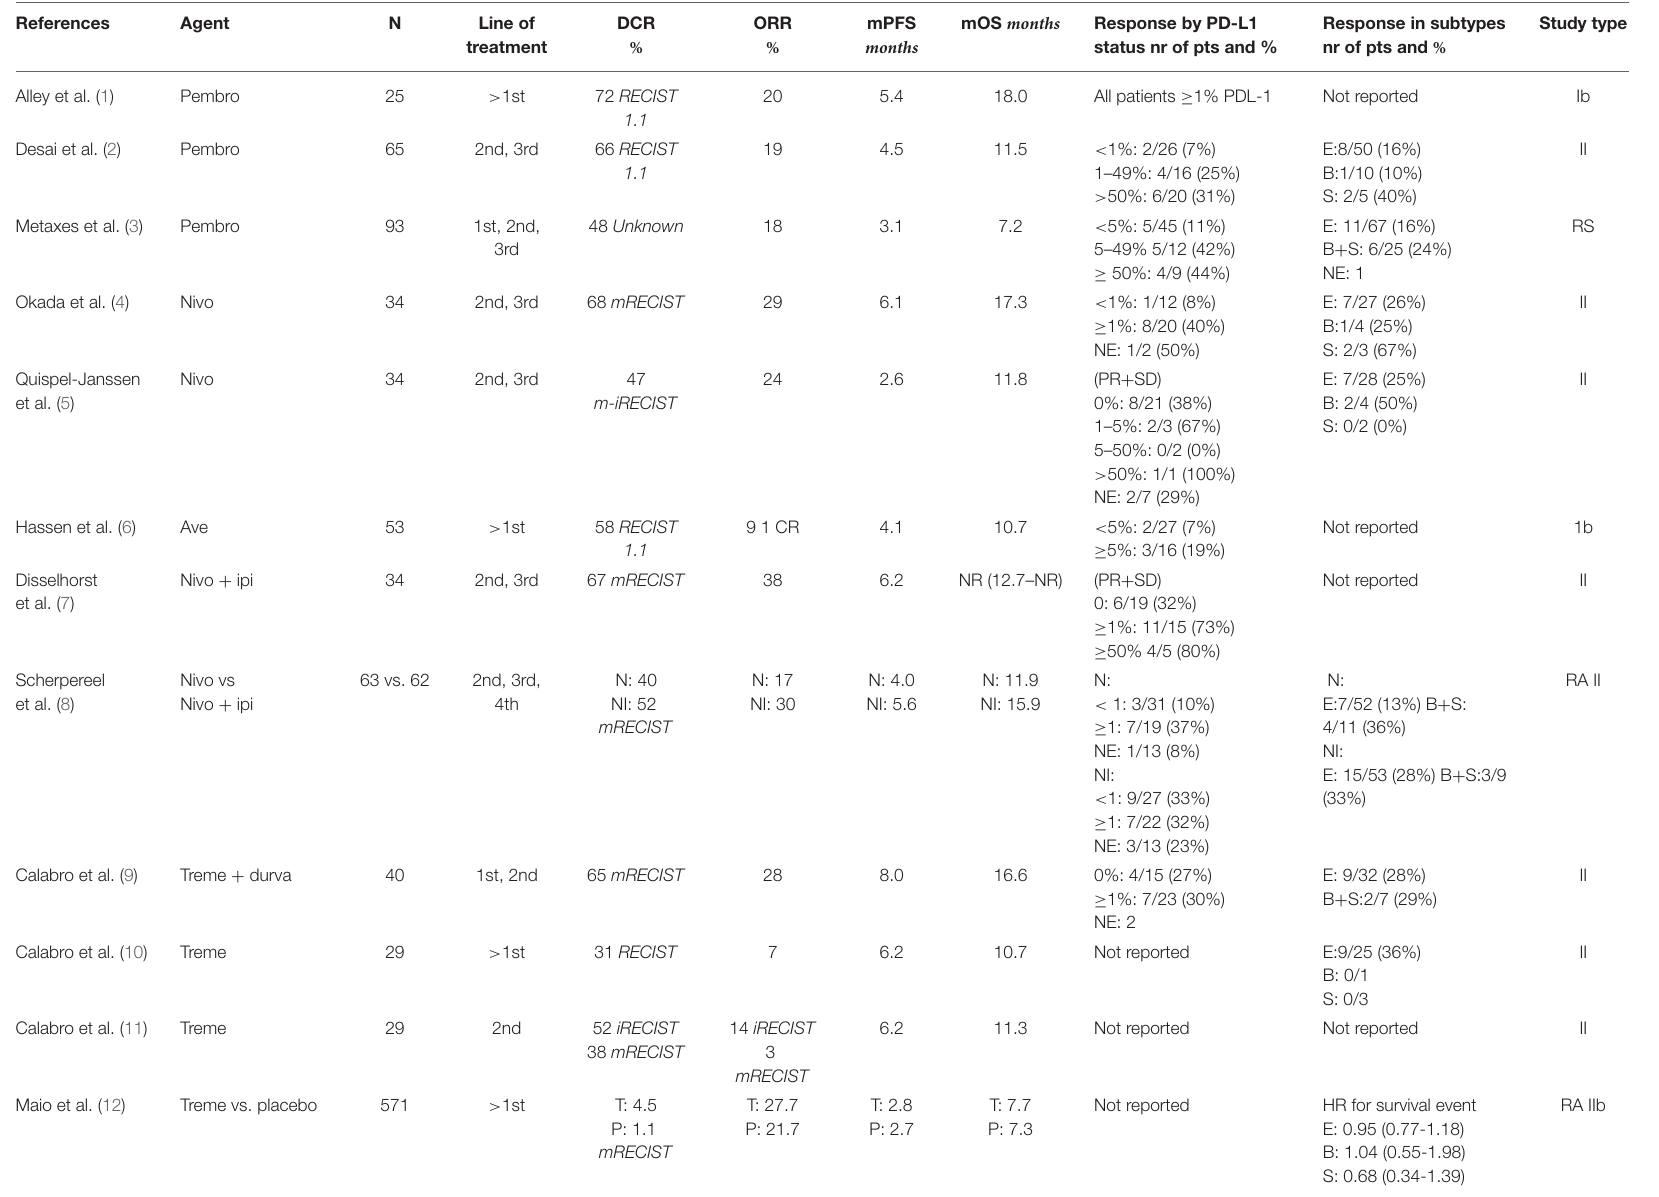
TABLE 1 | Overview of study